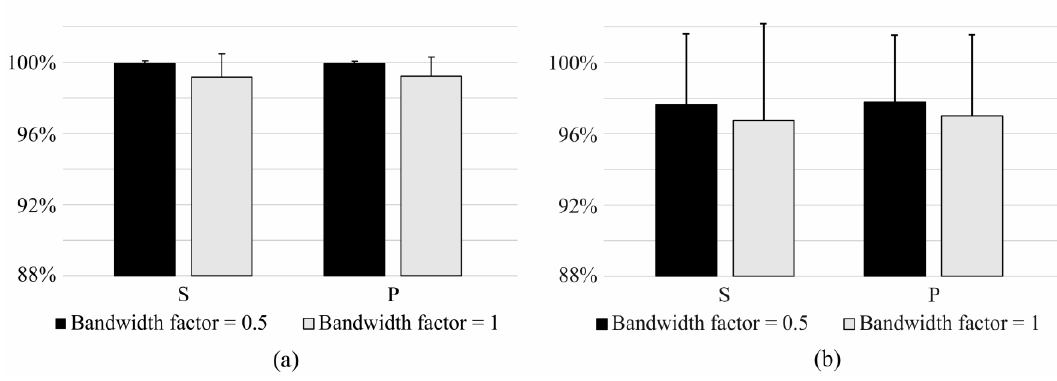
Figure 4. Sensitivity and precision of short-term identification of ( a ) identification of task and ( b ) identification of task and effort level using bandwidth factors 0.5 and 1.0 in mean shift algorithm.